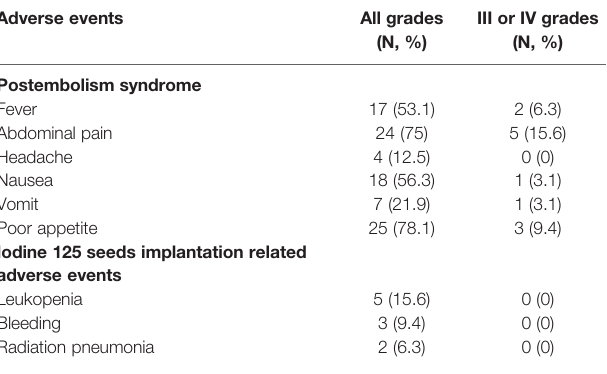
TABLE 6 | Adverse events of patients after receiving the treatments. Adverse events All grades